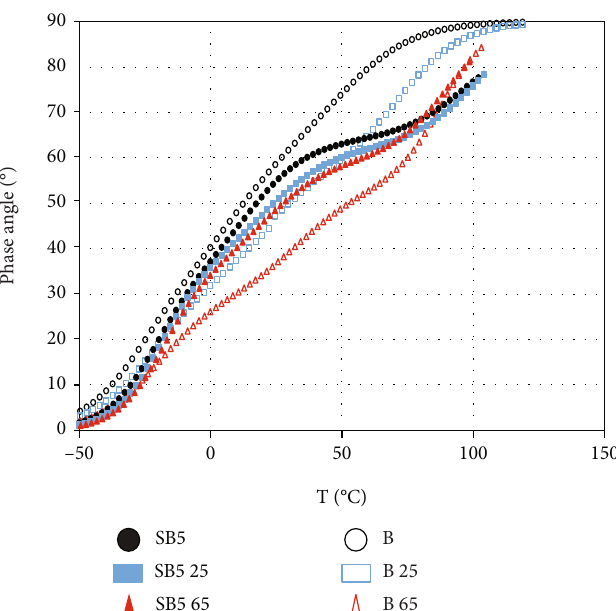
Figure 4: Phase angle as a function of temperature after transformation ω ⟶ T , T